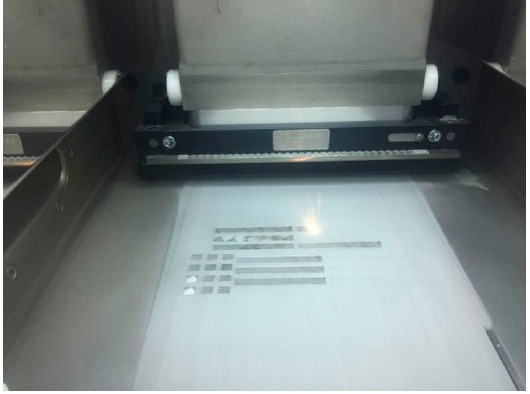
Figure 2. Selective laser melting of the cobalt-chromium alloy molding process.